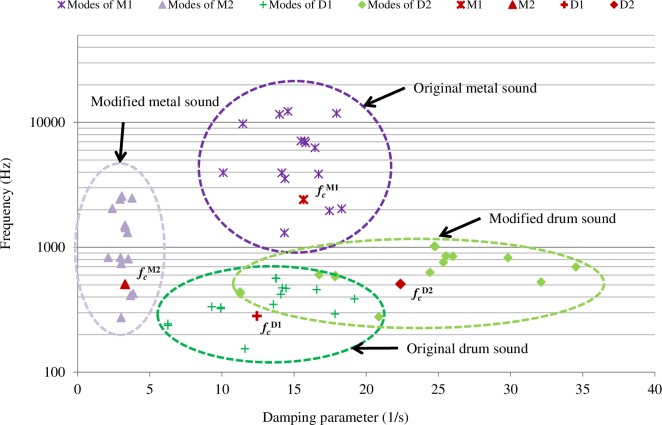
Modes of the original (M1, D1) and modified (M2, D2) sounds.